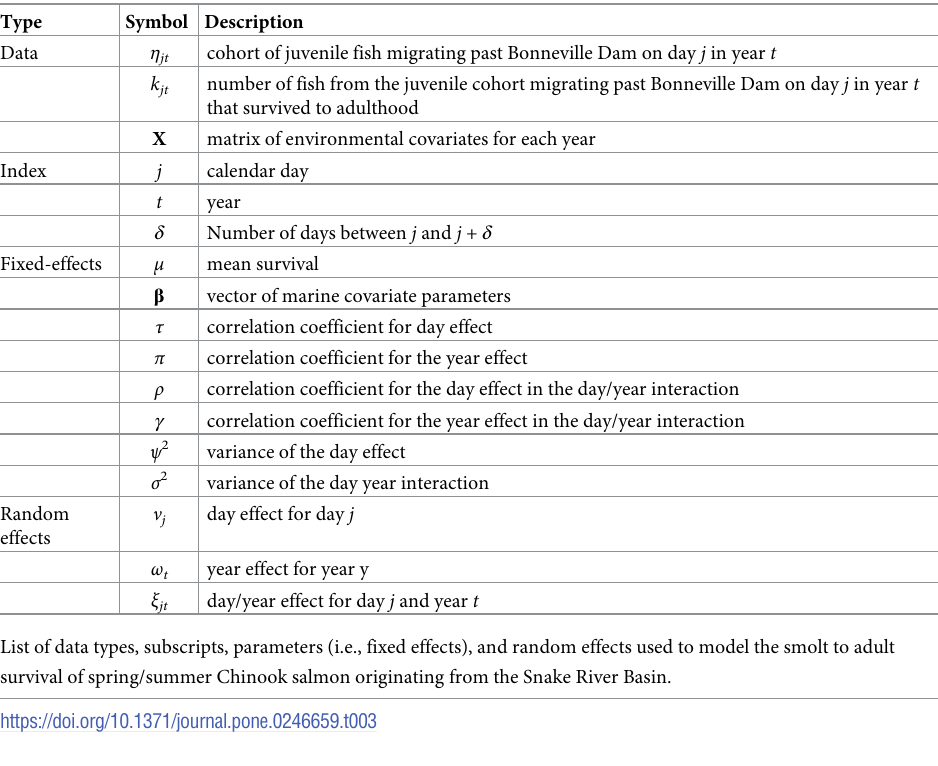
Table 3. Description of model symbols.